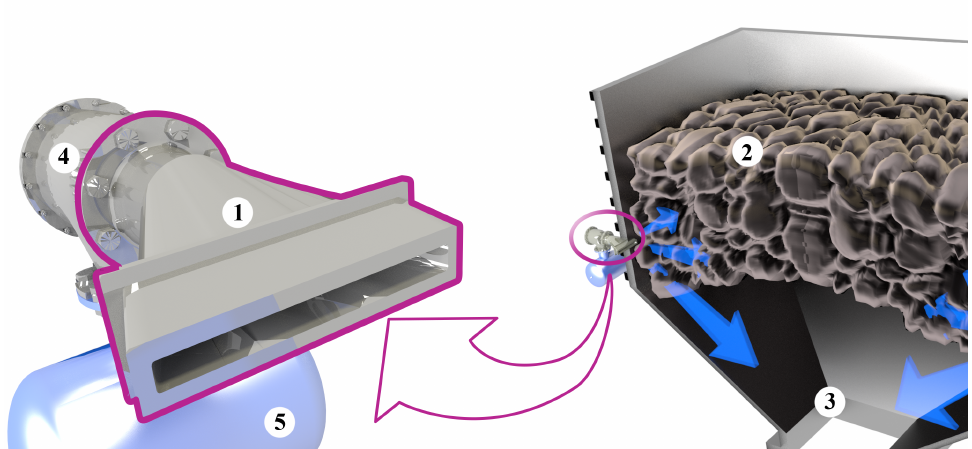
Figure 1. Visualization of the pneumatic pulsator system, and their location on silo walls: 1 —nozzle (outlined investigated object); 2 —loose material; 3 —silo (cross-section); 4 —head; 5 —pressure accu- mulator. Blue arrows show possible direction of